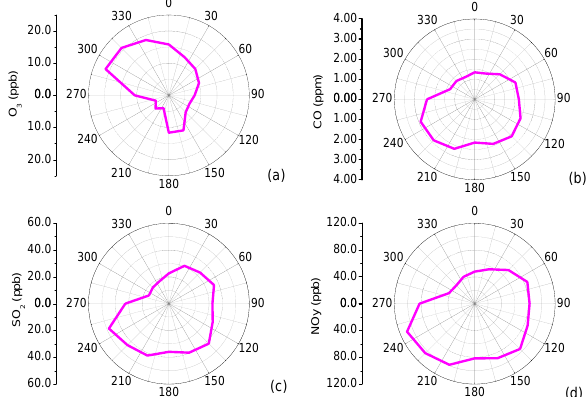
Fig. 7 The average concentrations of O 3 , NO y , SO 2 , and CO in corresponding wind Fig. 7. The average concentrations of O 3 , NO y , SO 2 , and CO in direction sectors. Strong winds from northwest help the transport of higher ozone level to corresponding wind direction sectors. Strong winds from northwest surface and facilitated the dilution of primary pollutants. help the transport of higher ozone level to surface and facilitated the dilution of primary